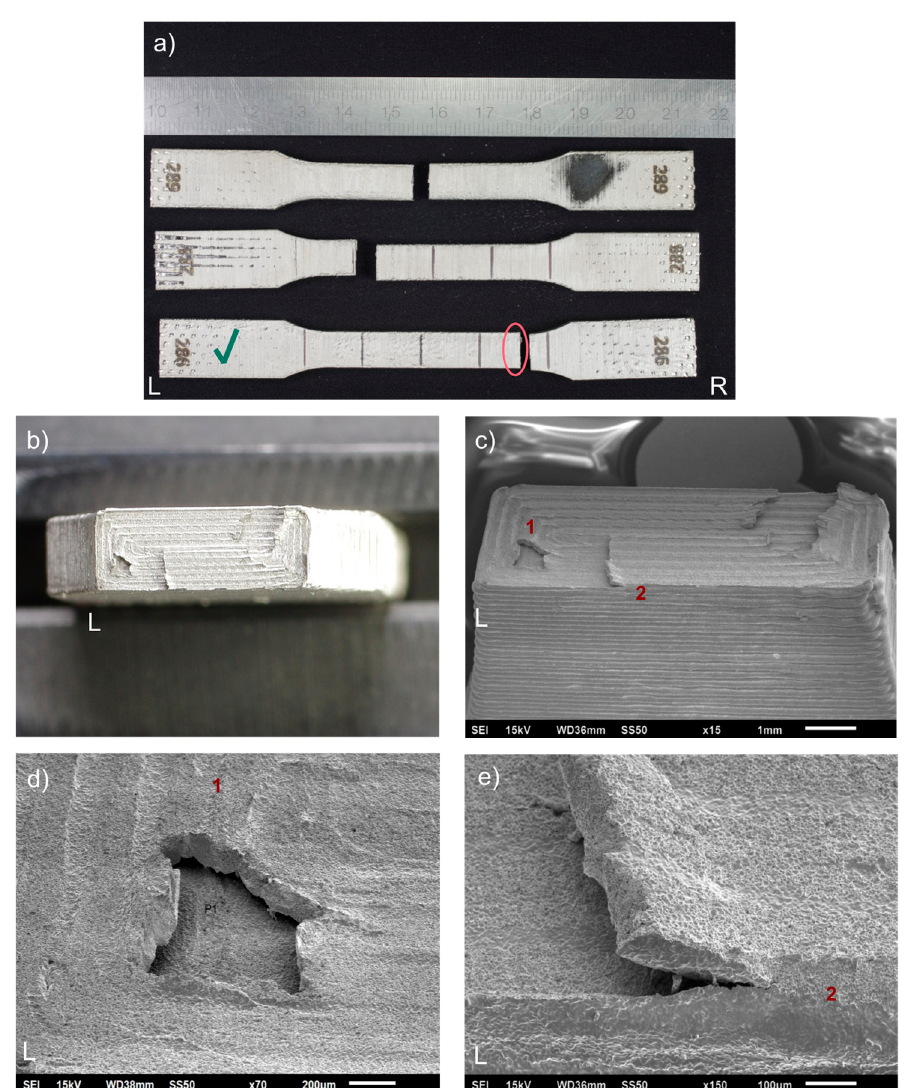
Figure 7. Fractures of tensile test 17-4 PH specimens presented as: ( a ) fractured specimens; ( b ) fracture surface, left side (optical microscope image), specimen 286; ( c ) fracture surface, left side (SEM image), specimen 286; ( d ) local delamination of a printed layer in the fracture, feature 1 (SEM image), specimen 286; ( e ) local delamination of the printed layer, feature 2 (SEM image), specimen 286. The samples have been numbered, which are visible in the figure. The letters L and R stand for the left-hand and right-hand sides of the sample in the figure. A green check mark means the specimen whose fracture faces were shown.